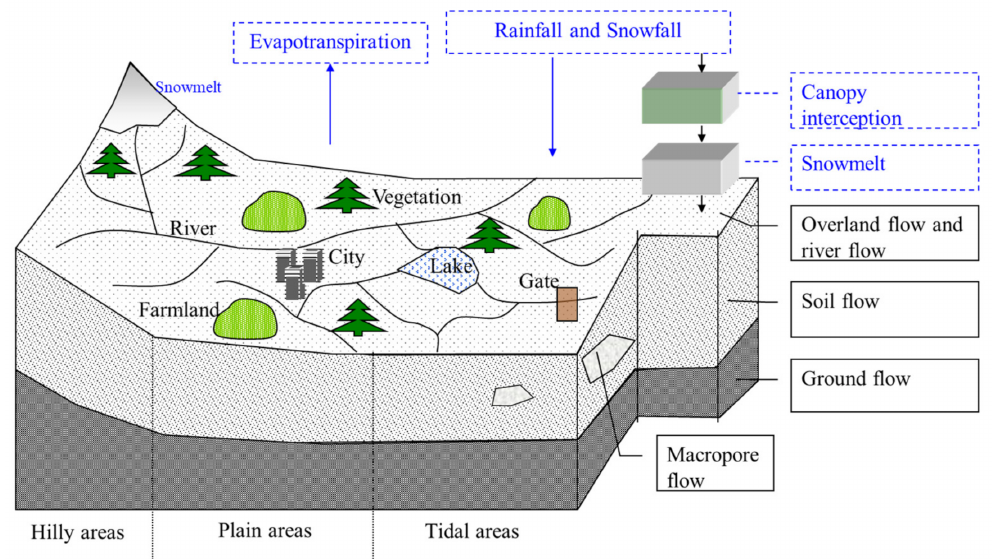
Figure 3. A schematic diagram for distributed-framework hydrological processes in the water cycle. The specific DF-PMS for the study area can be built when the HFUs are fixed and corresponding solving models are selected. The coupling of different HFUs represents multi-basin, multi-scale, and multi-process fusion in the hilly, plain, and tidal area, which covers not only hydrological processes, but also hydrodynamics. It is necessary to consider the time scale for the internal boundary conditions of each HFU. The major concern for the coupling of HFUs is the water exchange between the interface of different HFUs. When the water exchange occurs in one direction during the period or the variation of the time scale is large, the explicit coupling mode is applied for some interfaces of HFUs, such as the runoff generation of hilly sub-watershed HFU enter into the nearby hilly river HFU. In other words, the explicit coupling mode can be used between HFUs of the runoff generation type or between HFUs of the runoff and confluence type. However, for HFUs of runoff movement, the water exchange is frequent and the time scale is small. We have to apply the implicit coupling mode, especially between HFUs in the surface layer, such as the river and lake feature unit and the weir-sluice feature unit in plain areas. For the confluence unit between different vertical stratification, such as groundwater, the explicit coupling mode is applied due to the large time scale and one-way exchange in a certain